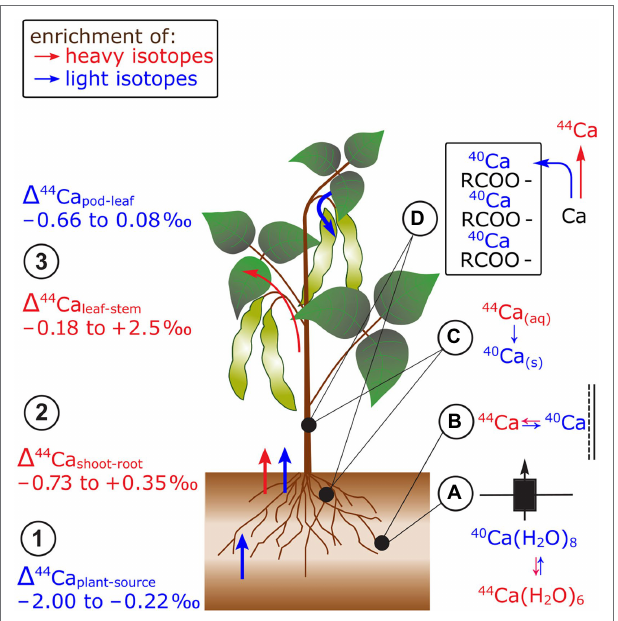
FIGURE 5 | Ca isotope fractionation in plants exemplified for beans. (1) Root uptake of Ca leads to an enrichment of light isotopes. (2) In most cases, shoots are enriched in heavy isotopes compared to roots. (3) Leaves are preferentially enriched in light isotopes compared to stems while reproductive organs are mostly lighter than leaves. The preferential uptake of light isotopes has been ascribed to (A) isotope differences in hydrated Ca species with distinct number of water molecules and (B) the preferential sorption of light Ca isotopes to negatively charged surfaces in the root apoplast. Within the plant, (C) lighter isotopes may precipitate with oxalate ( 40 Ca) and (D) are structurally bound in cell walls to pectins (RCOO − groups). The retention of light Ca isotopes leads to a higher mobility of heavy Ca isotopes within